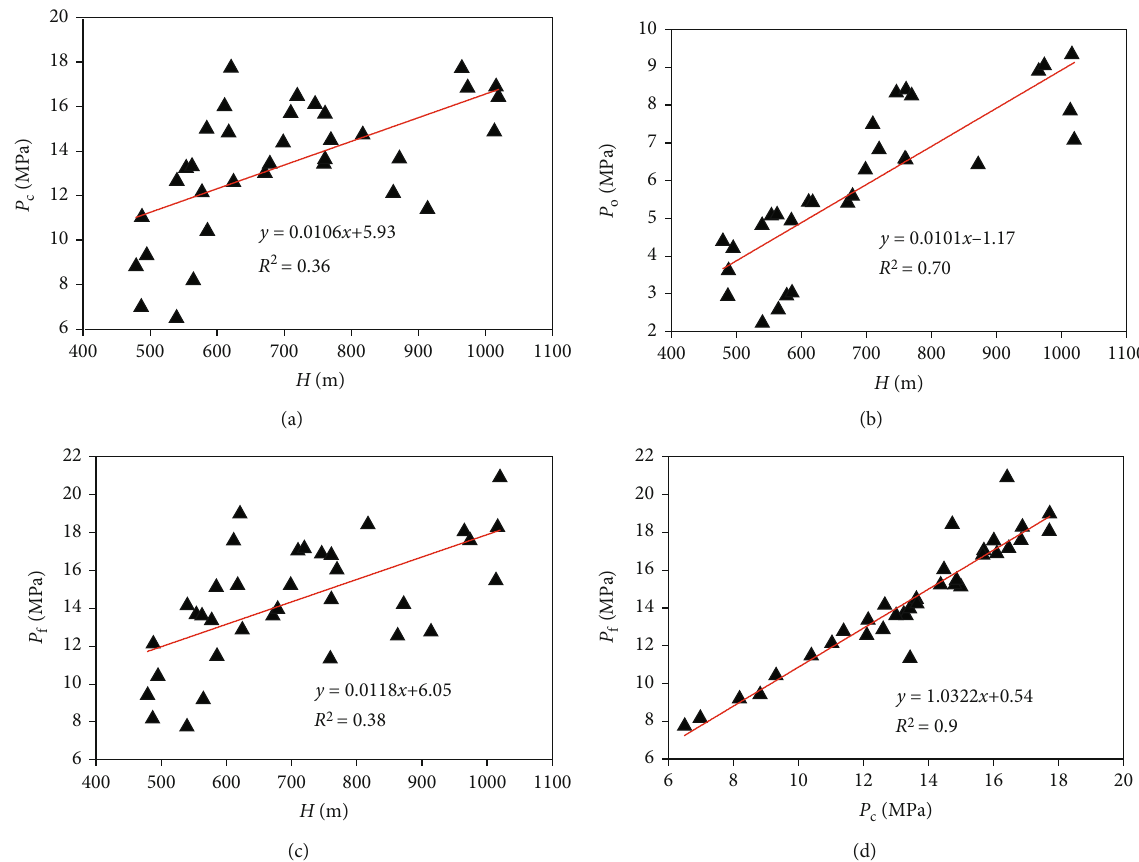
Figure 5: Scatter diagrams of reservoir pressure, fracture pressure, closure pressure, and burial